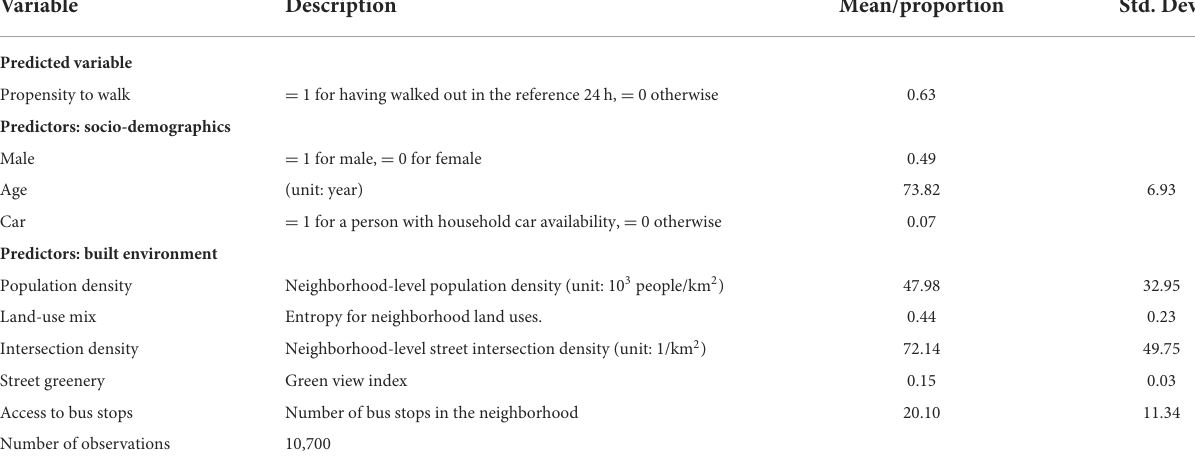
TABLE 1 Summary of the predicted variable and